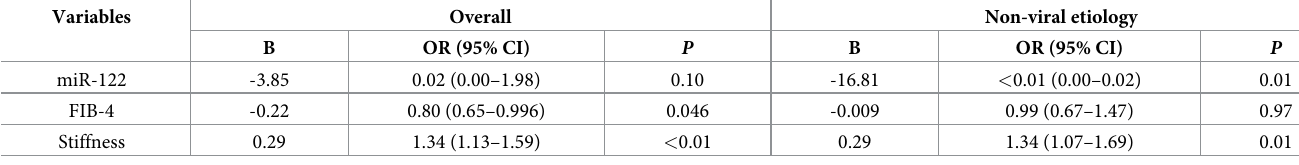
Table 3. Multivariate analysis of variables predicting advanced liver